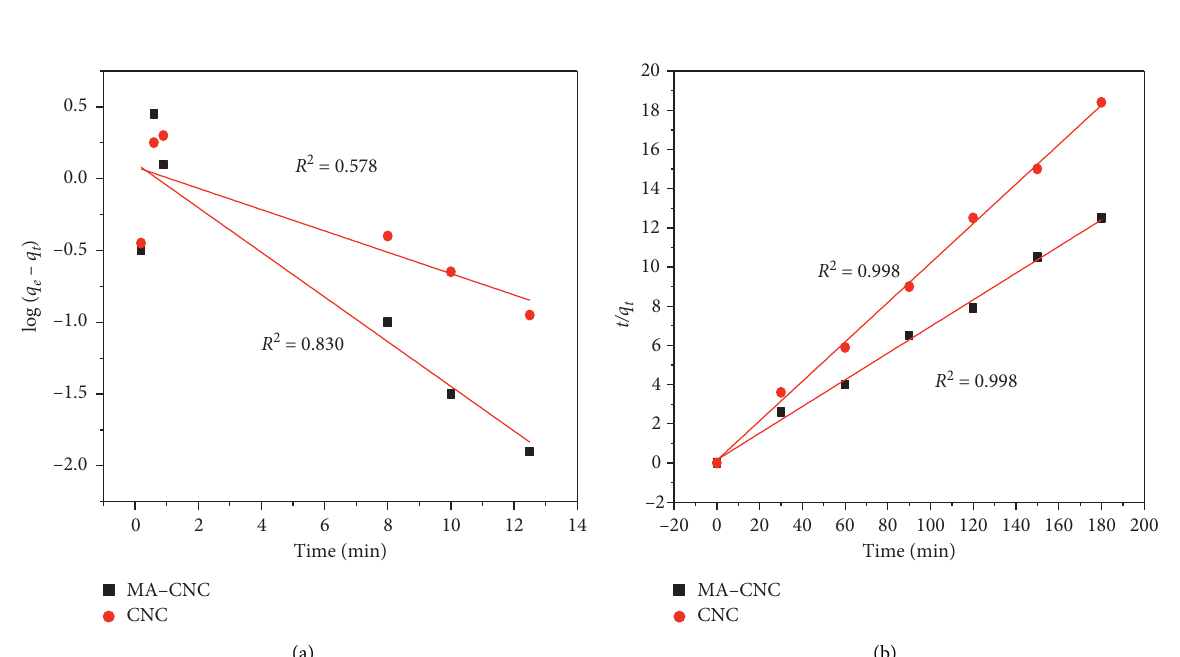
Figure 10: Plot of the PFO (a) and PSO (b) model (at C speed � 250rpm) for Cd(II) ion removal,